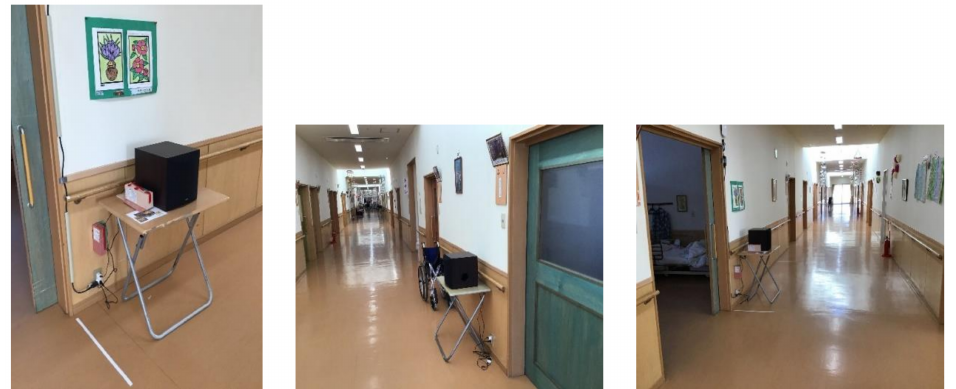
Figure 2. Installation view of the